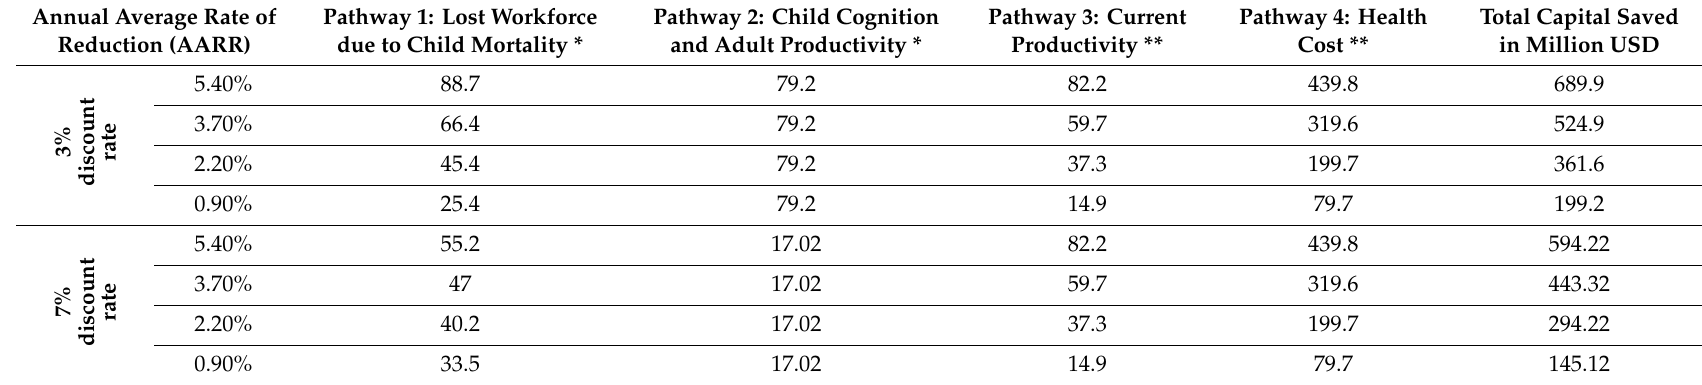
Table 3. Potential savings with averted wasting cases over the next 10 years